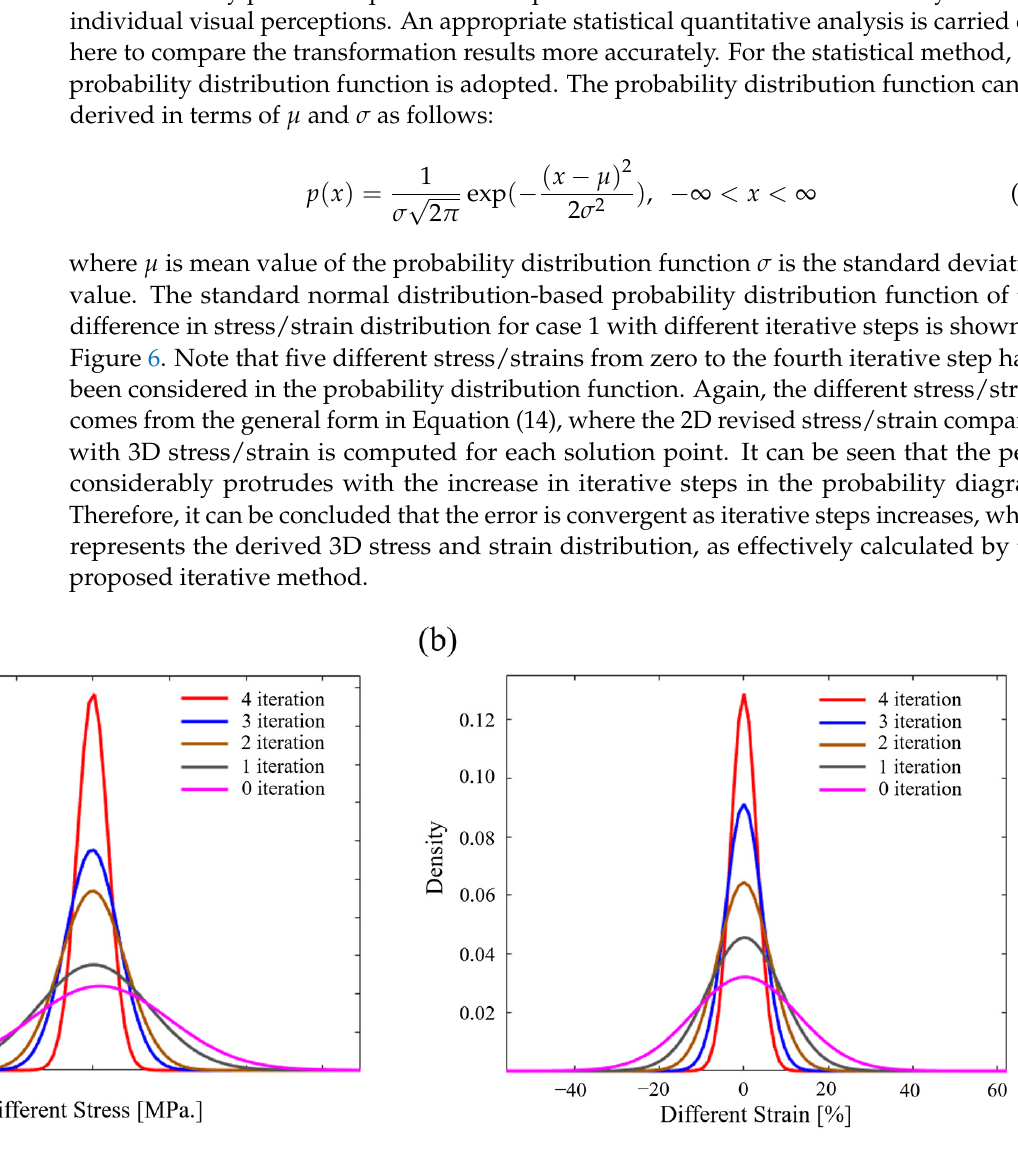
13 of 19 Figure 5. Convergence analysis for the ferrite phase at 25% global true strain. ( a ) Stress and ( b ) strain by the proposed iterative method with different iterative steps.